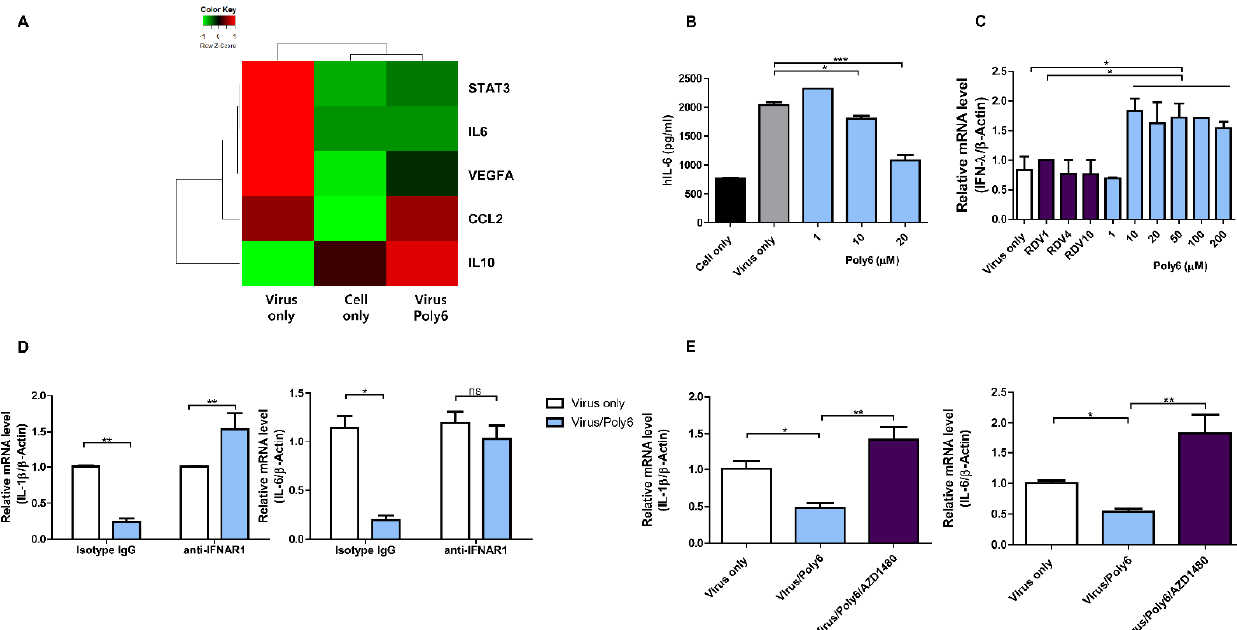
Figure 5. Poly6 inhibits pro - inflammatory cytokine production in SARS - CoV - 2 - infected Calu - 3 cells. ( A ) A heatmap of STAT3, IL - 6, VEGFA, CCL2, and IL - 10 was constructed using the qPCR array in Calu - 3 cells infected with SARS - CoV - 2 and treated with Poly6. The colors show fold changes as ddCt normalized by an endogenous control (GAPDH) and comparing Virus - only or Poly6 groups to uninfected cells. ( B ) The IL - 6 cytokine immunoassay was performed with human IL - 6 ELISA. ( C ) IFN - λ mRNA expression levels in Calu - 3 cells treated with PBS, RDV, or Poly6 following SARS - CoV - 2 infection. ( D , E ) Calu - 3 cells were pre - incubated with isotype IgG or IFNAR1 antibodies (10 µg/mL) for 2 h at 37 °C ( D ). Calu-3 cells were pre - treated with AZD1480 for 2 h at 37 °C ( E ). After SARS - CoV - 2 infection, PBS or Poly6 was added for 24 h. Cells were collected, and RT - qPCR was performed to analyze the mRNA levels of IL - 1β and IL - 6. Genes were normalized to β - actin, and data are shown as fold changes. The experiments were performed in triplicate and repeated twice for confirmation. Data represent the mean ± SD and * p < 0.05, ** p < 0.01, *** p < 0.001, ns: not significant.